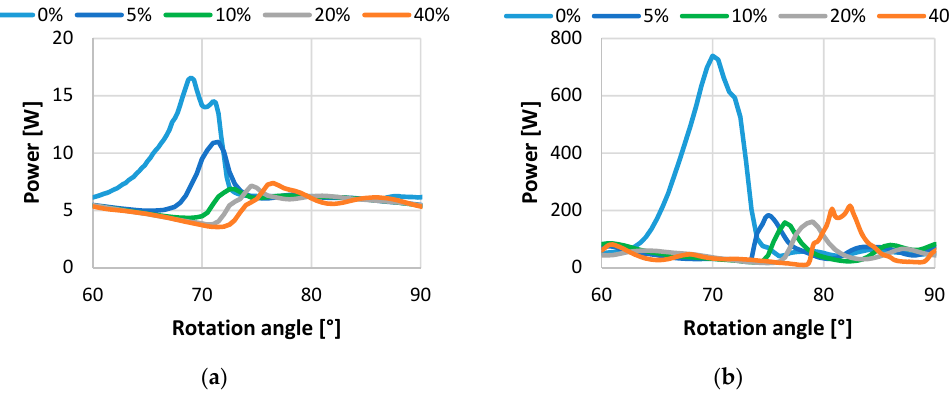
Figure 31. Influence of the IGVF of free air on the instantaneous power demand at 5-bar delivery pressure, ( a ) 500 and ( b ) 4000 rpm.